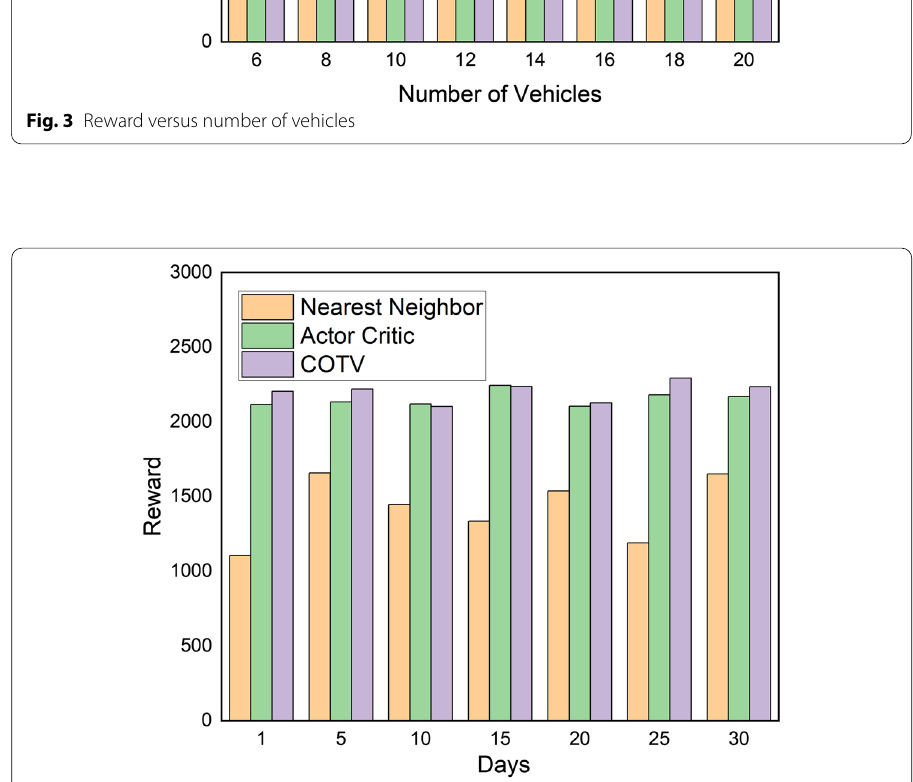
Fig. 4 Reward versus